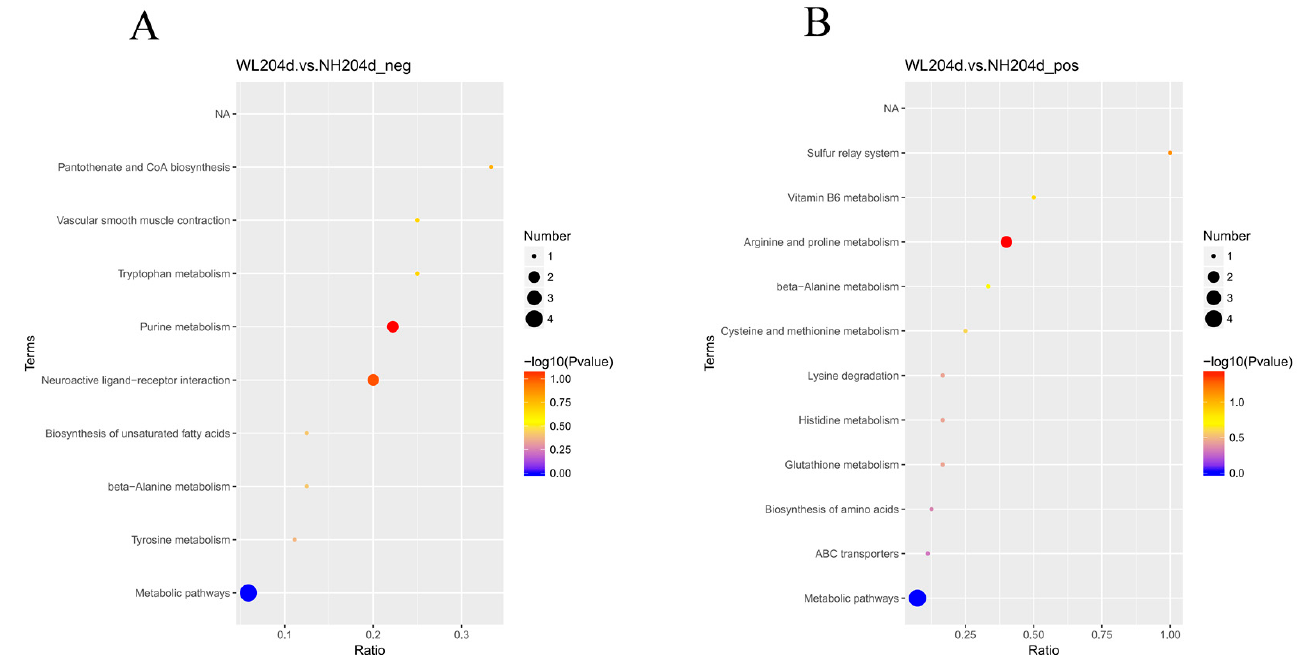
Figure 4. KEGG enrichment analysis for SDMs. ( A ) KEGG enrichment of significantly differential metabolites in the negative model; ( B ) KEGG enrichment of significantly differential metabolites in the positive model.